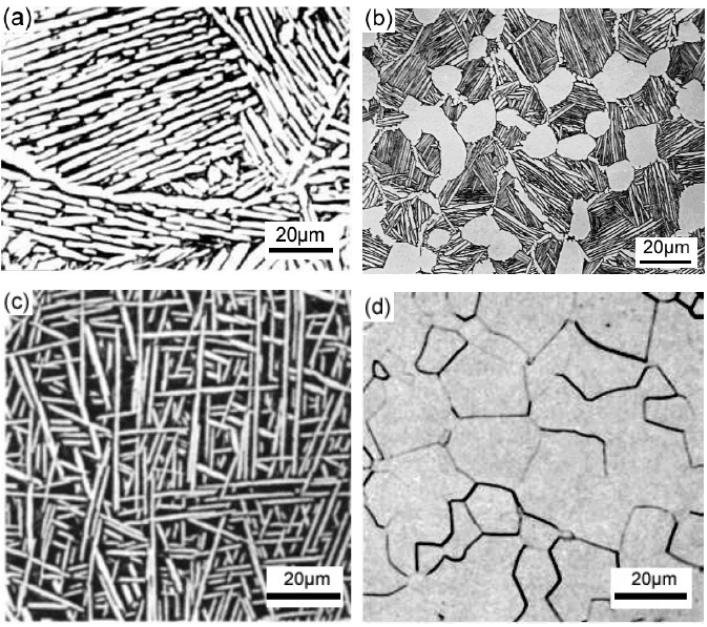
Figure 1. Typical microstructures of α + β titanium alloys: ( a ) Widmanstätten; ( b ) duplex microstructure; ( c ) basket-weave microstructure; ( d ) equiaxed structure (adapted from